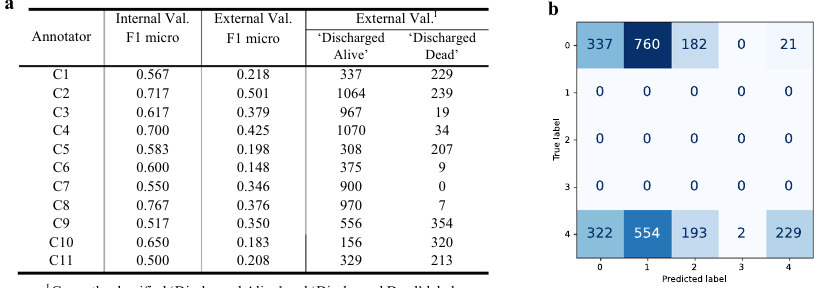
Fig. 5 Comparison of internal and external validation performances of the RF models across all 11 consultants (C1-C11). a Internal and external validation performances of the consultants ’ RF models. For each classi fi er, the number of correctly classi fi ed “ Discharged Alive ” and “ Discharged Dead ” labels on the HiRID external dataset are reported. b External validation confusion matrix plot for Consultant 1, showing the HiRID dataset true labels and RF model predicted labels across the fi ve classes (A-E): 0 = ICU-PSS label ‘ A ’ , 4 = ICU-PSS label ‘ E ’ .